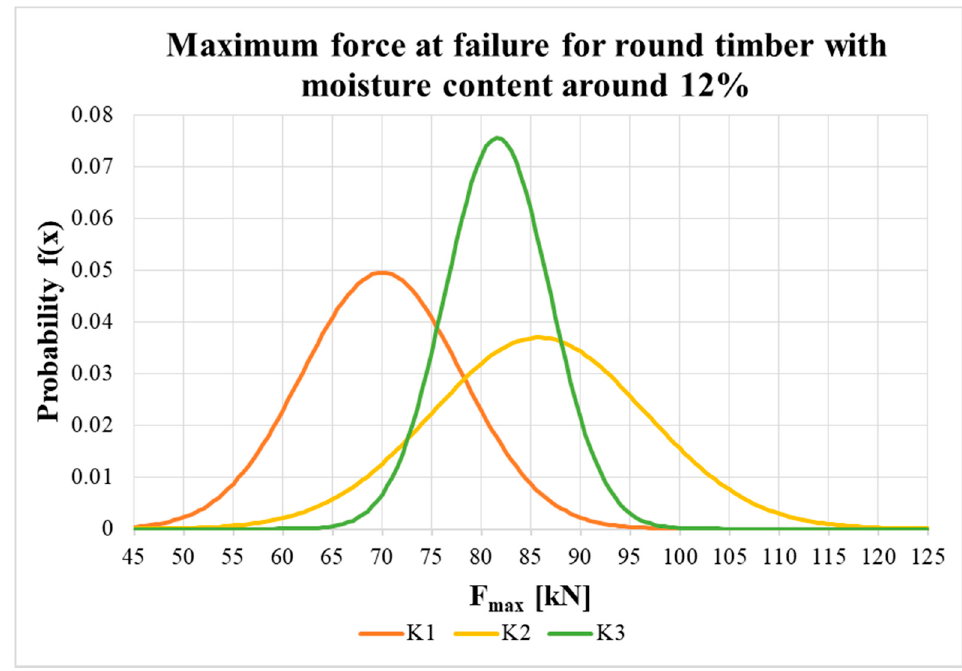
Figure 16. Probability density function of maximum force at failure for K1, K2 and K3.